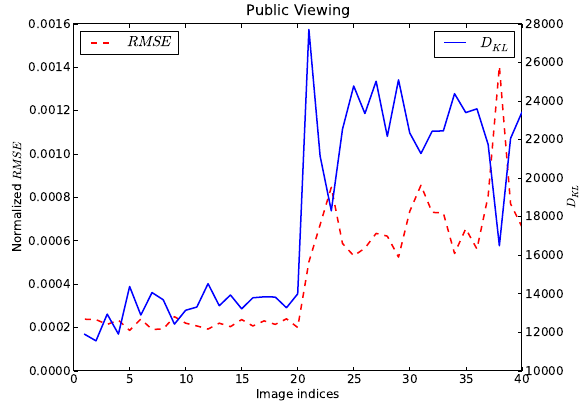
Figure 4: RMSE and D KL for the Publicviewing dataset. The steep slope between images 20 and 21 marks the border between images with lowest and highest errors.